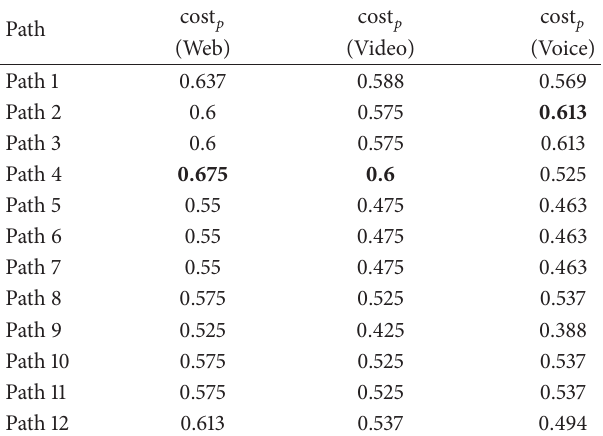
Table 5: The values of cost 𝑝 at the beginning of the simulation.